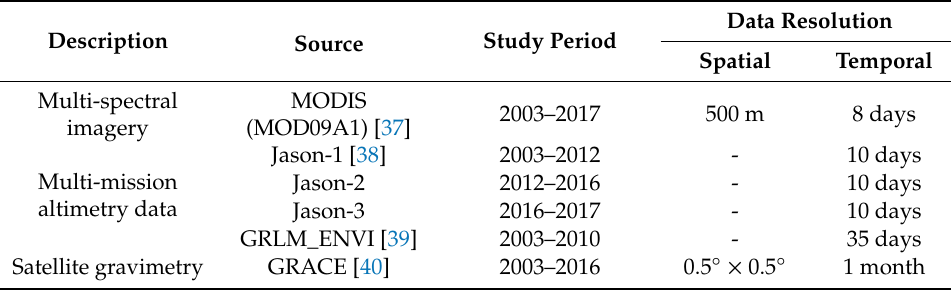
Table 1. Summary of data in the study.